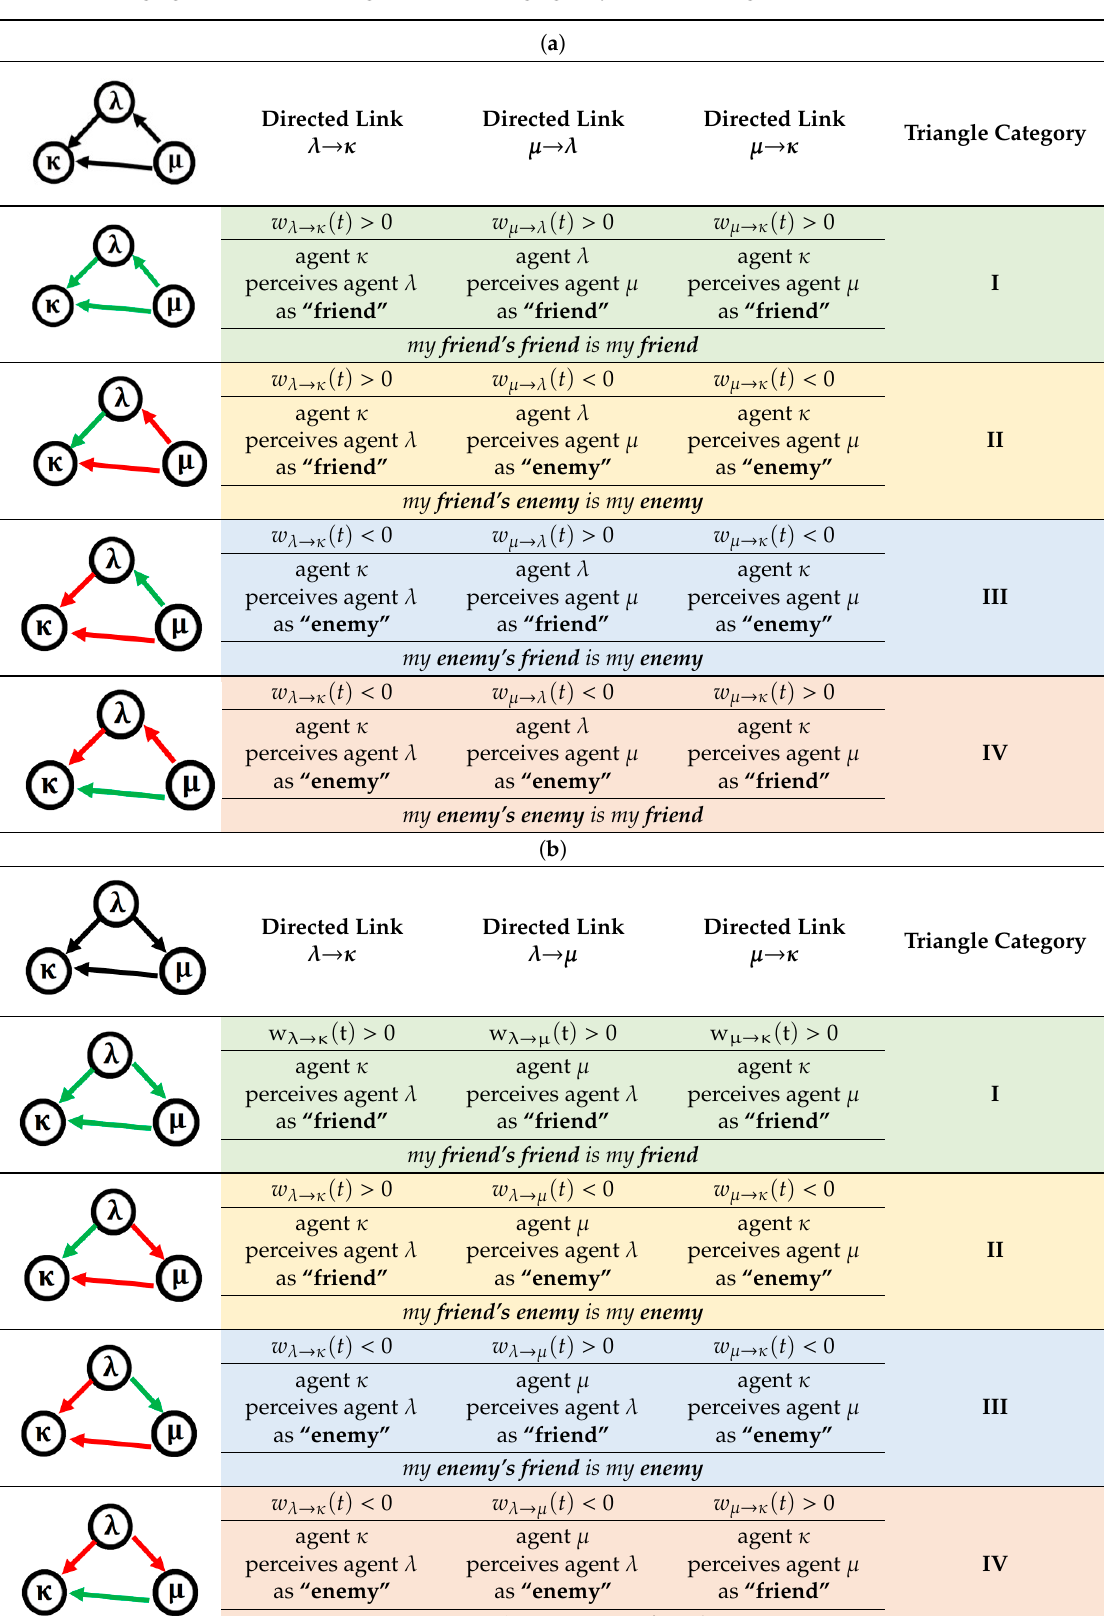
Table 2. b. Balanced Directed Triangles, with respect to agent (cid:2018) (two incoming links to agent (cid:2018) ), having agent (cid:2020) as “middle agent”